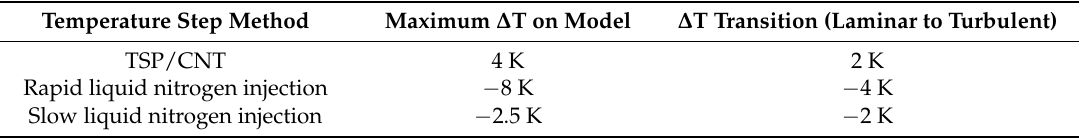
Table 2. Temperature changes on the model surface for conditions shown in Figure 13.